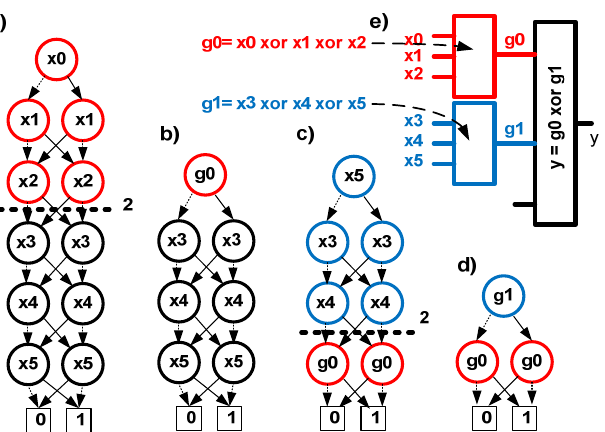
Figure 3. Technology mapping of the xor function in three inputs LUTs: BDD in the next steps of decomposition ( a – d ), the result of technology mapping ( e ). The ideas presented may be, depending on the strategy, aimed at minimizing the number of blocks or minimizing the number of logical levels. The main drawback of these approaches is the complete disregard of power consumption.